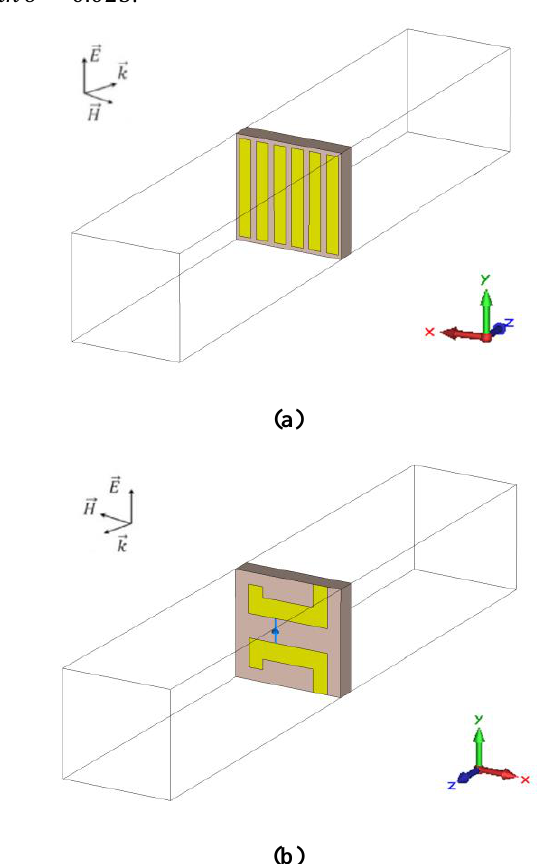
Figure 2: Front (a) and back (b) side view of the unit cell’s simulation model in CST studio environment, lumped element used as the diodes between two neighboring